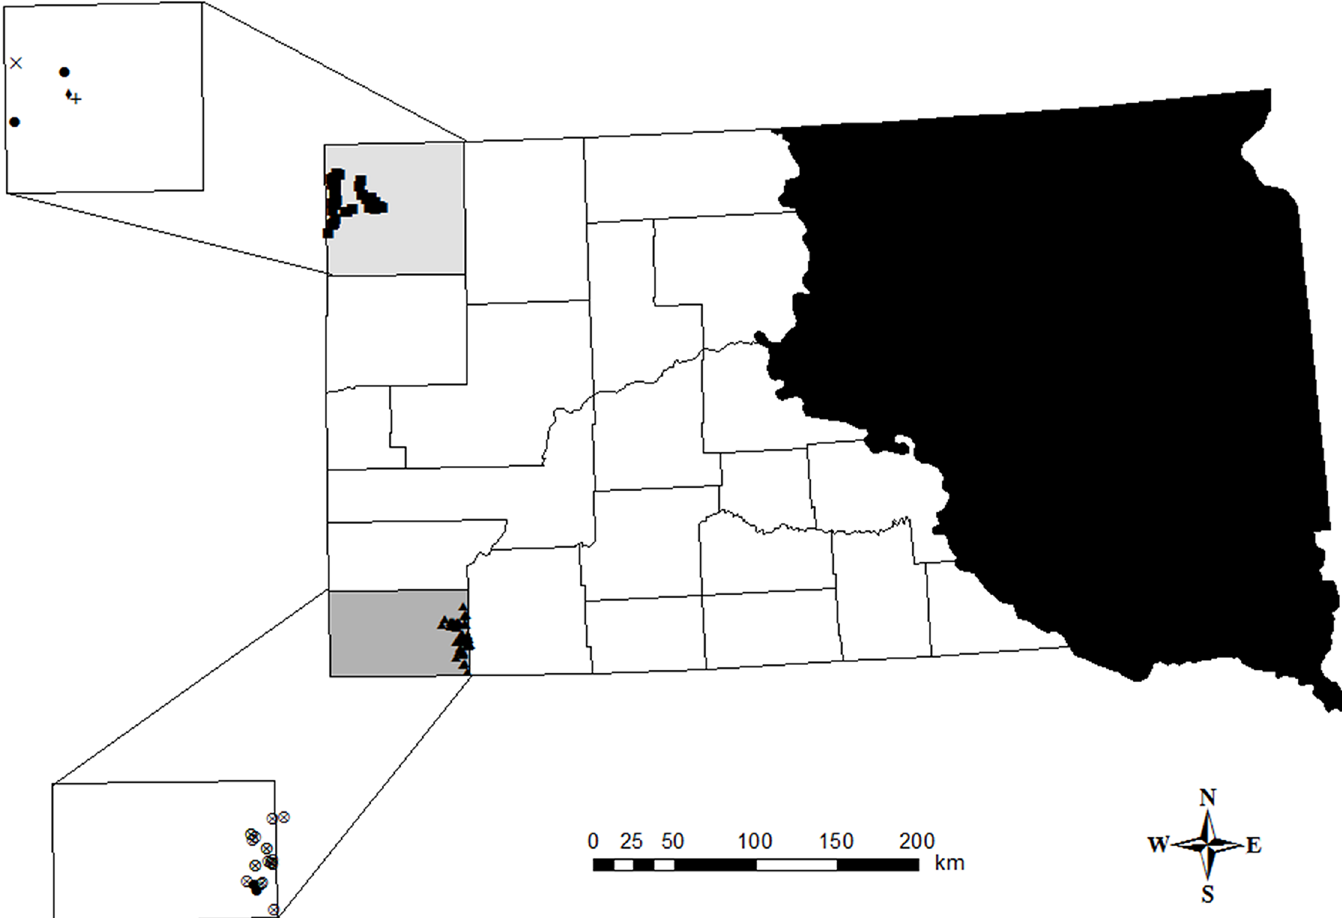
Fig 1. Neonatal pronghorn ( Antilocapra americana ) capture locations were located in Harding (gray shaded county in northwest region of state) and Fall River (light gray shaded county in southwest region of state) of western South Dakota, 2002 – 2005. Thin black lines delineated county boundaries and the black shaded region encompassing eastern South Dakota represented the area outside current pronghorn range. ■ denotes Harding County neonatal capture locations. ▲ denotes Fall River County neonatal capture locations. ♦ = neonatal death by cattle trampling, (cid:1) = neonatal death by predation, + = neonatal death by abandonment, (cid:129) = neonatal death by unknown causes, and × = neonatal death by vehicle collision.